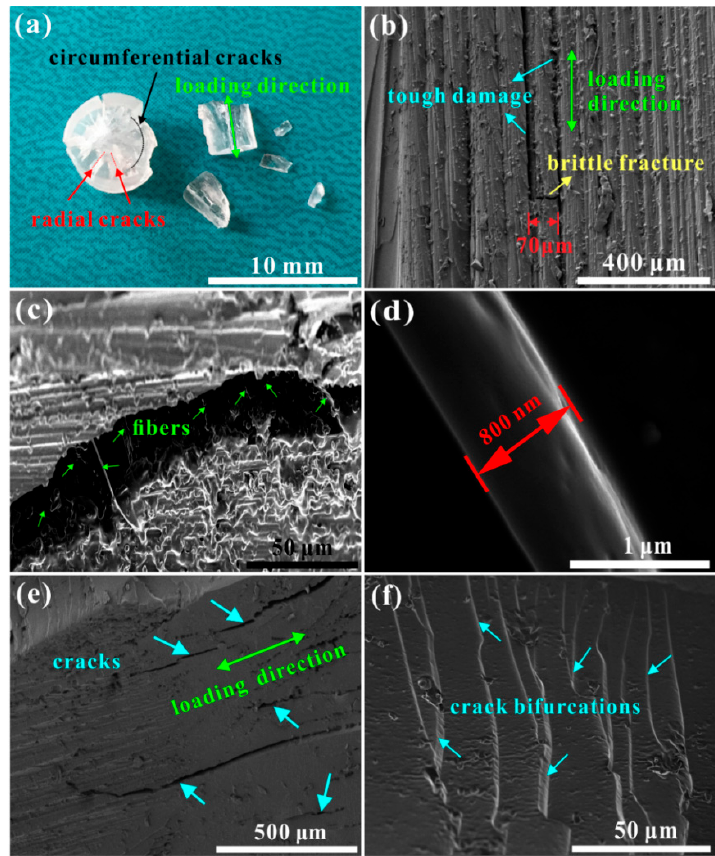
Figure 7. Post-test observations on the deformation and fracture behavior for revealing the mechanisms of dynamic yielding and straining of the developed PUE material: ( a ) cracking pattern and fracture mode; ( b ) uniform deformation bands elongated in the loading direction with two kinds of cracks; ( c ) fine fibrils linking an opening crack localizing between the deformation bands; ( d ) 800 nm diameter of a fibril; ( e ) numerous cracks formed after a considerable straining; and ( f ) brittle cracking behavior to fracture deformation bands, resulting in the final dynamic failure.